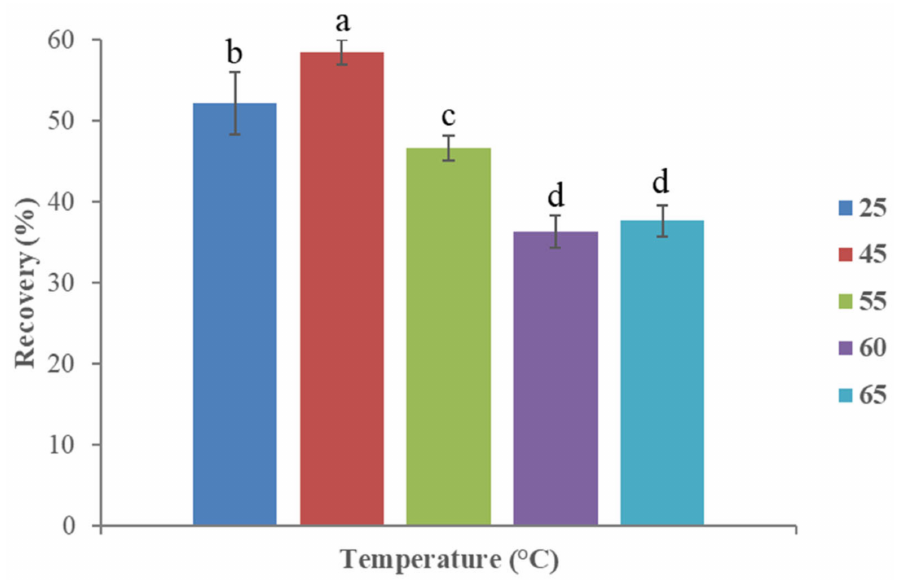
Figure 3. Effect of temperature on the extraction recovery of carotenoids from LTW; standard deviation of three replicate analyses, is presented with error bars; different letters (i.e., a–d) denote samples that differ significantly (statistical difference for p <